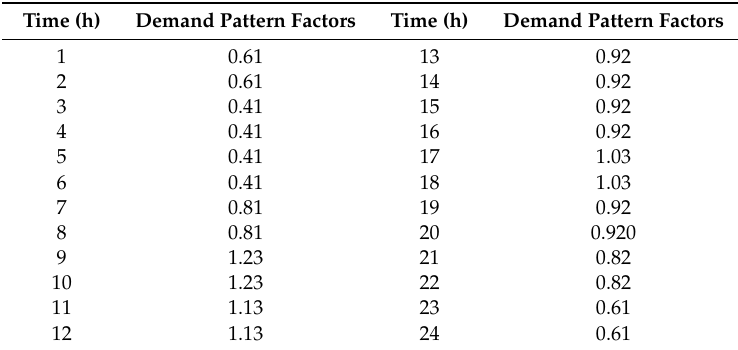
Table 1. Daily Demand Pattern Factors.